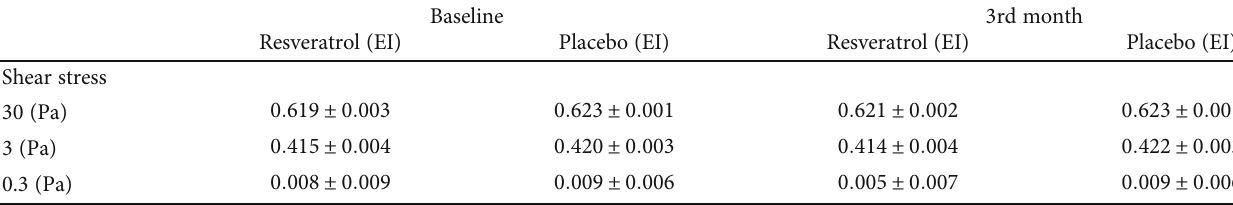
Table 3: E ff ect of resveratrol on red blood cell deformability.